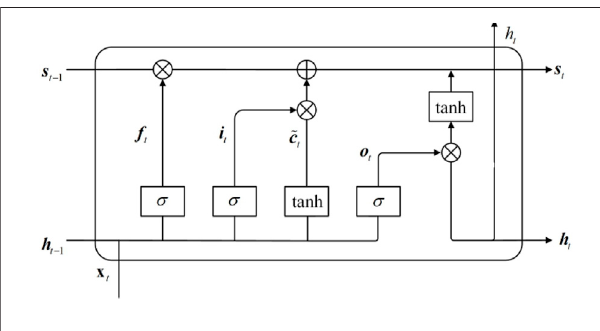
FIGURE 1 | Unit structure of